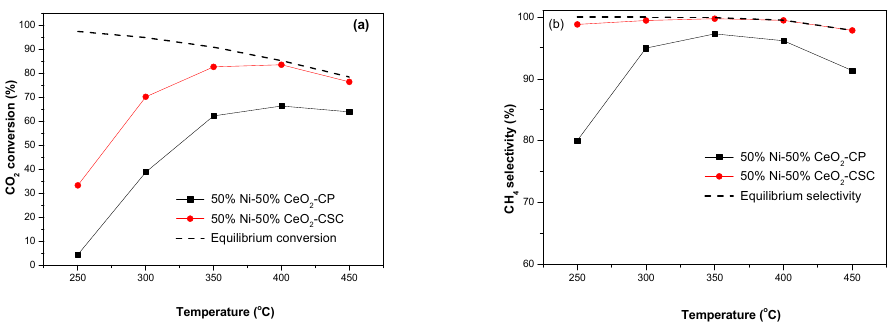
Figure 6. ( a ) CO 2 conversion and ( b ) CH 4 selectivity over the 50% Ni-CeO 2 -CSC and 50% Ni-CeO 2 -CP catalysts in CO 2 methanation.